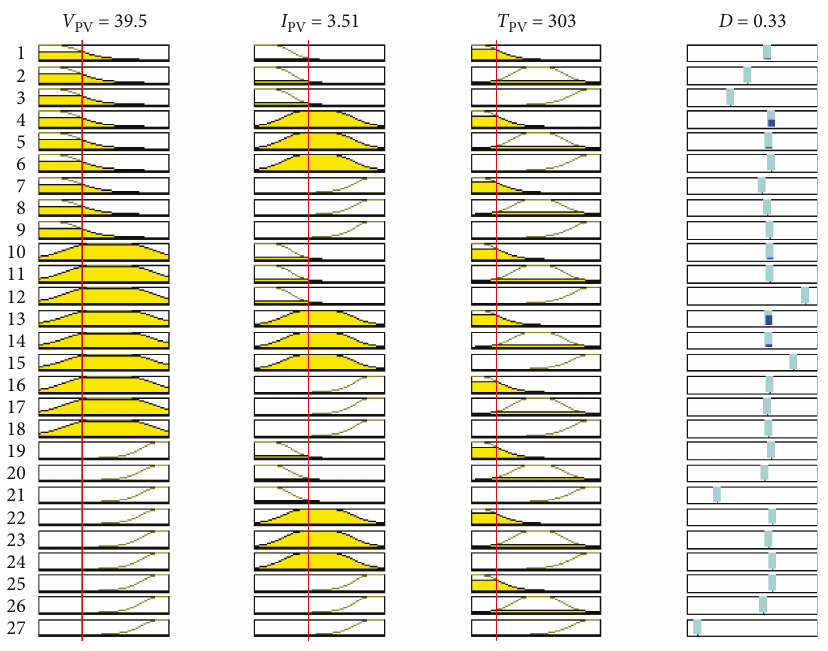
Figure 11: Rule base of ANFIS controller.